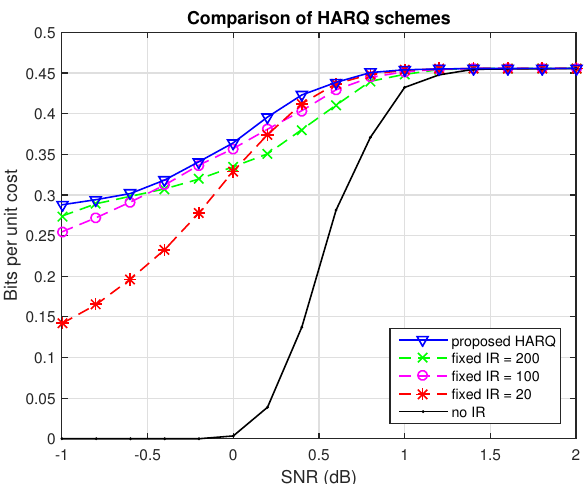
Figure 6. Throughput of different incremental redundancy (IR) schemes for a single link.